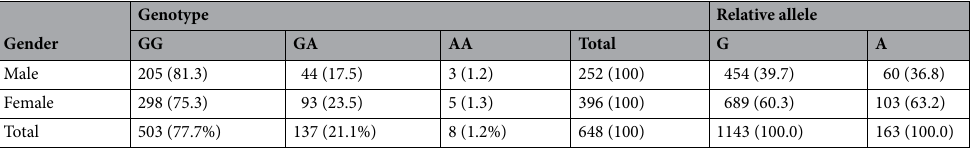
Table 1. Distribution of Genotype and allele frequencies of EcoR1 polymorphism of the Apo B gene in patients with type 2 diabetes mellitus. Values are frequency (percent).